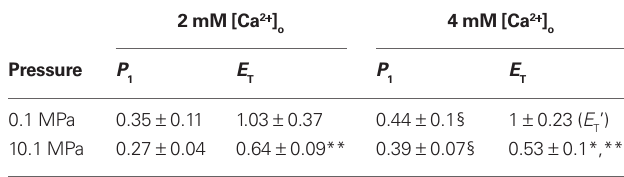
Table 1 | estimation of E conditions.